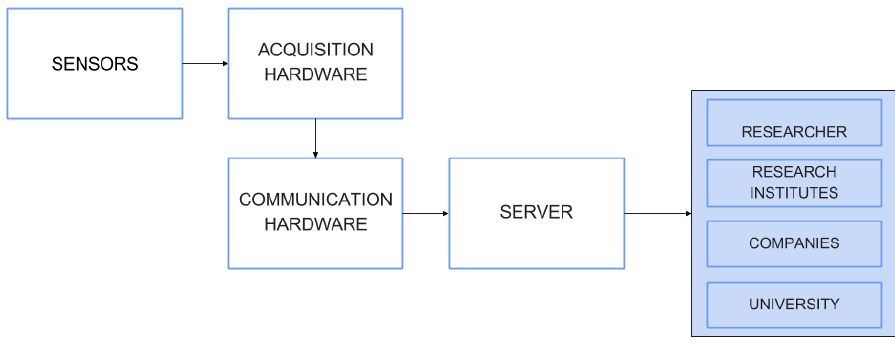
Figure 3. Working flow of the proposed